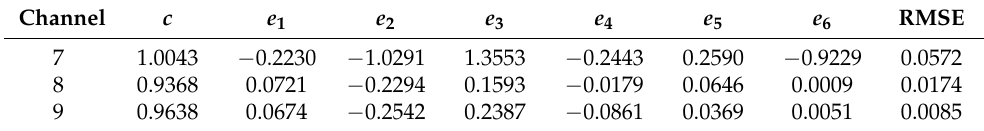
Table 1. Empirical coefficients for estimating the